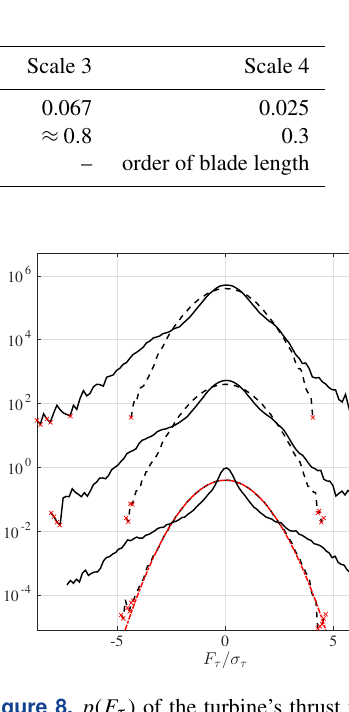
Figure 7. p ( u τ ) of both velocity time series shown in Fig. 5, A (dashed) and B (solid), for τ = { 25 , 67 , 80 ms , 2 s } from top to bot- tom. The different scales are shifted vertically for presentation. A Gaussian fit (dashed red line) of p ( u τ = 2 s ) for inflow A is added to guide the eye. Table 3. First two statistical moments of the time series shown in Fig. 5 and their turbulence intensities. Values are rounded to two decimal places.